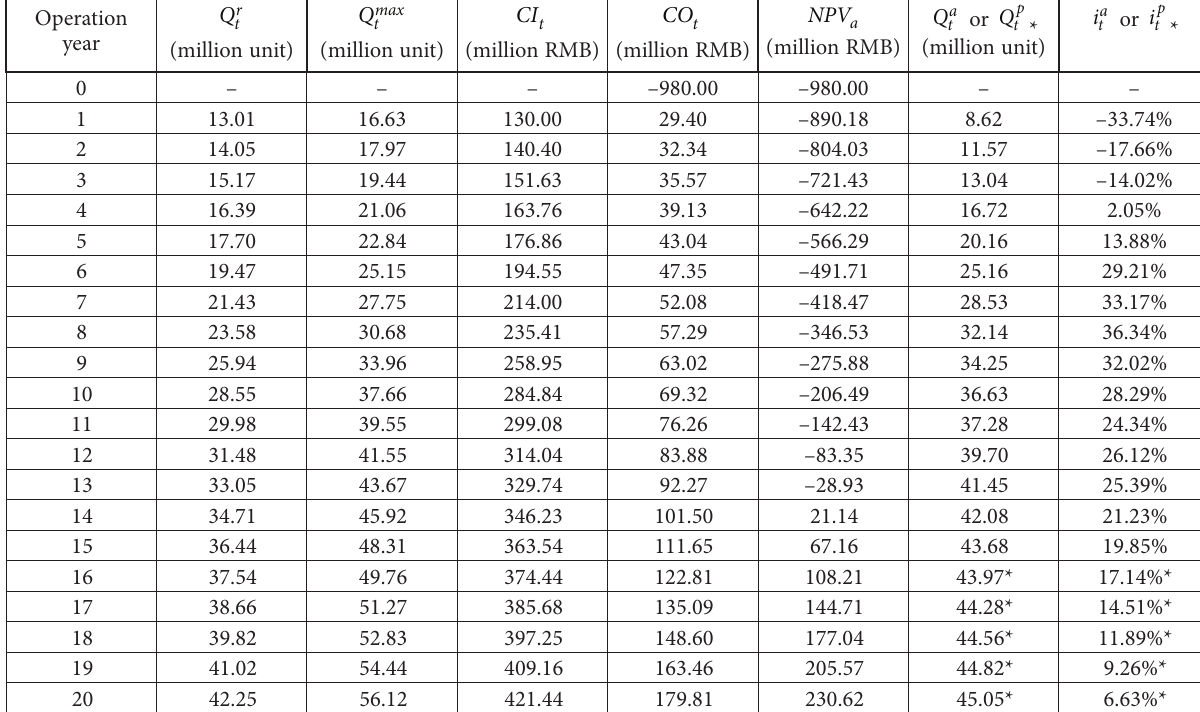
Table 2. Summary of cost and benefit